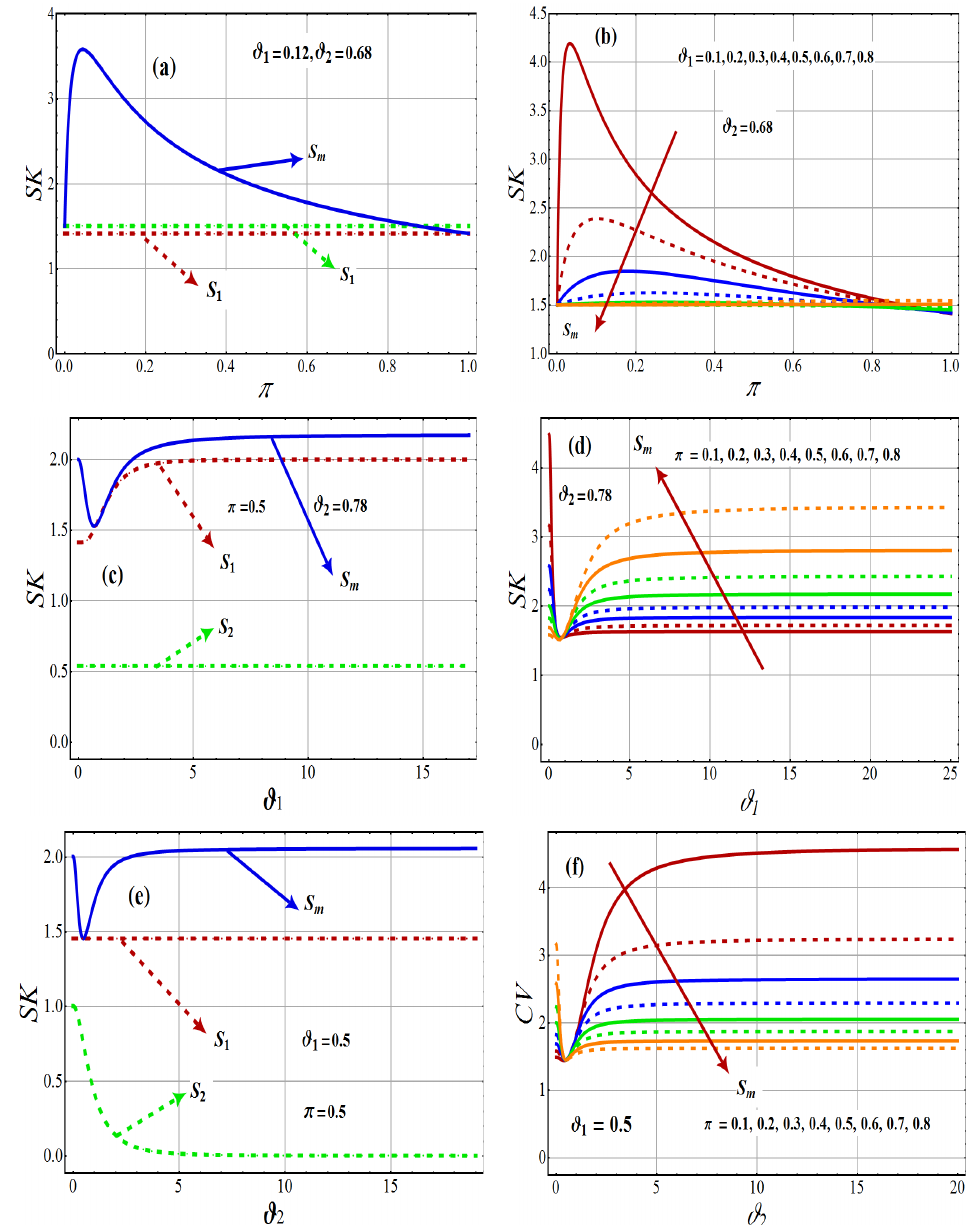
Fig. 5. Variations of Coe¢ cient of Skewness, for (cid:133)rst component ( S Figure 5. Variations of coefficient of skewness, for first component ( S 1 ), for second component ( S 2 ), and for 2-CMSM ( S m ).